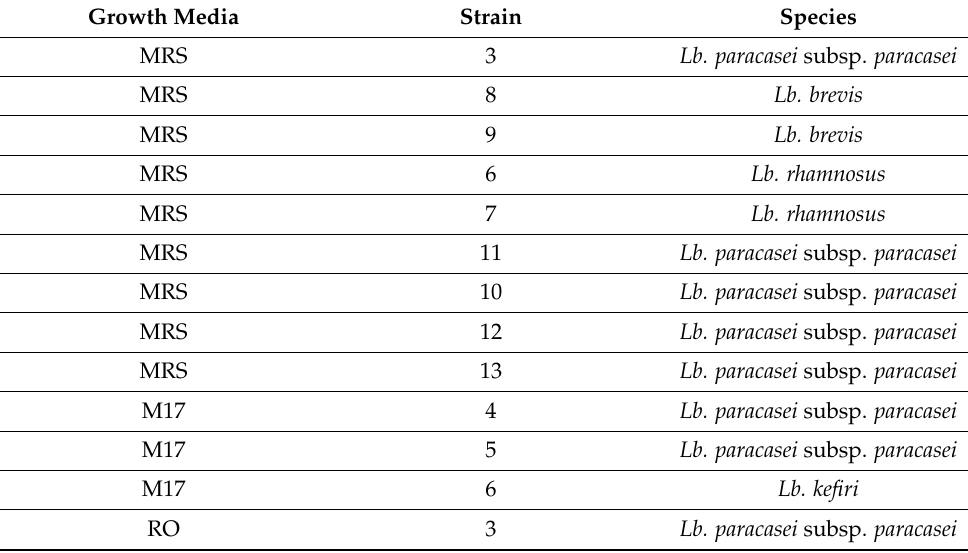
Table 3. Identification of isolated bacilli using classical